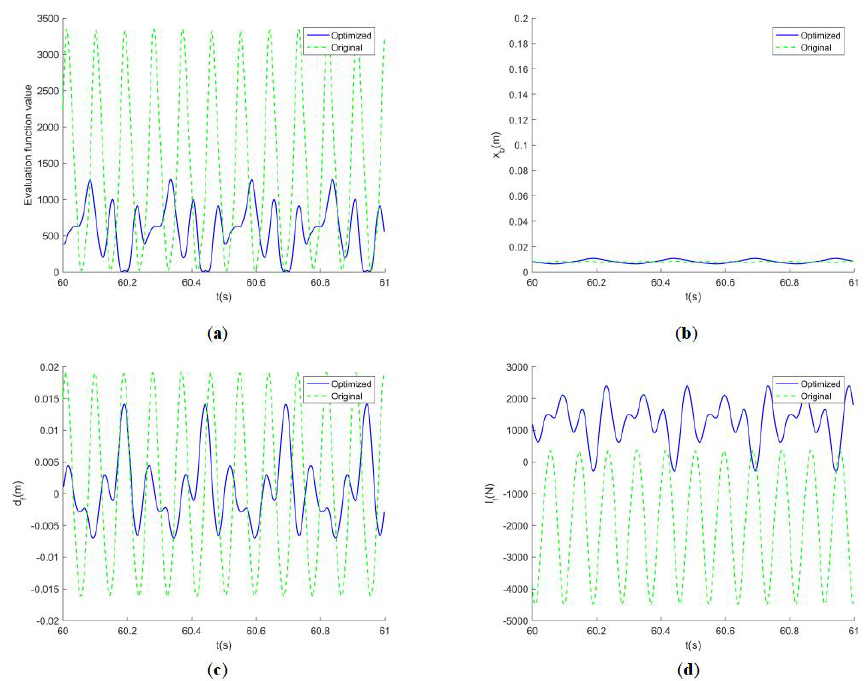
Figure 6. Comparison of system response curves of each parameter of a passive suspension vehicle before and after optimization. (a) Objec- tive function F . (b) The vehicle body’s vertical displacement. (c) The front suspension’s dynamic deflection. (d) The front wheel’s dynamic